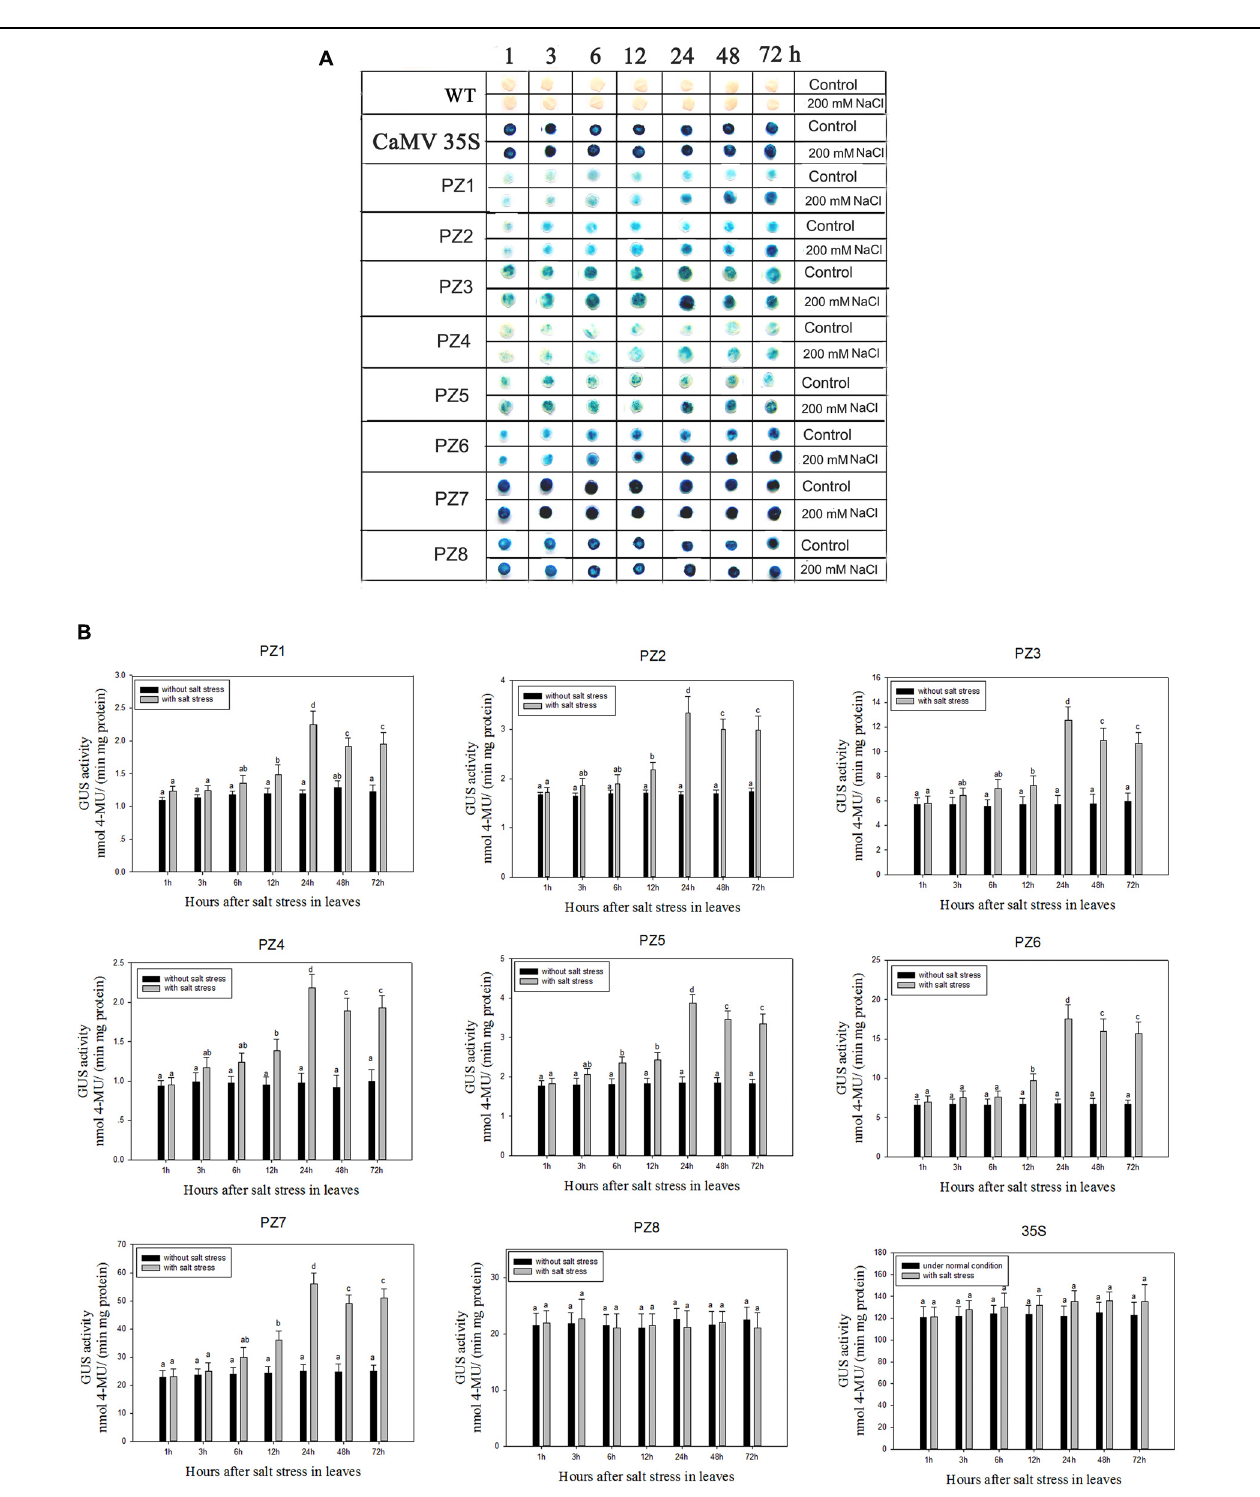
FIGURE 5 | GUS histochemical staining and fluorescent quantitative analysis of transgenic tobacco expressing eight truncated promoter of pZmPIS::GUS under normal and salt stress conditions. (A) GUS histochemical staining; (B) GUS fluorescent quantitative analysis. The tobacco plants were incubated in the liquid 1/2 MS medium supplemented with 200 mM NaCl for 1, 3, 6, 12, 24, 48, and 72 h. The plants grown in the liquid 1/2 MS medium were treated as control. Values represent the mean ± standard deviation from three independent transgenic lines and each line five individual plants for each construct. Different lowercase letters above the bars indicate significant differences at P <